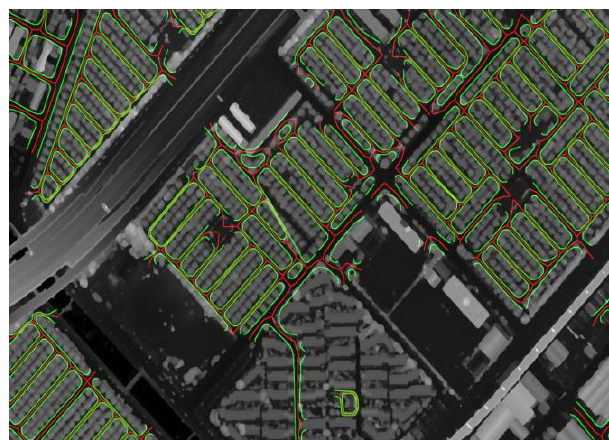
Figure 5 Road lines and the original